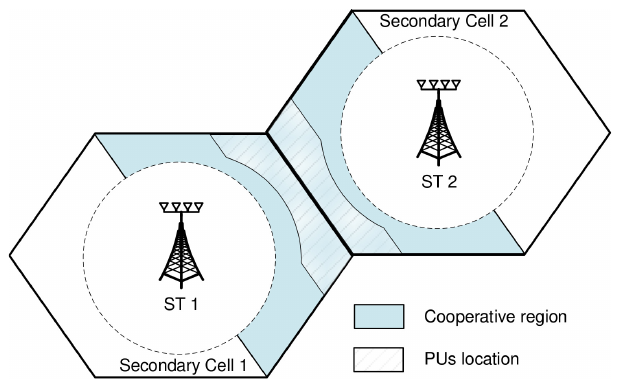
Figure 2. A cooperative region in the